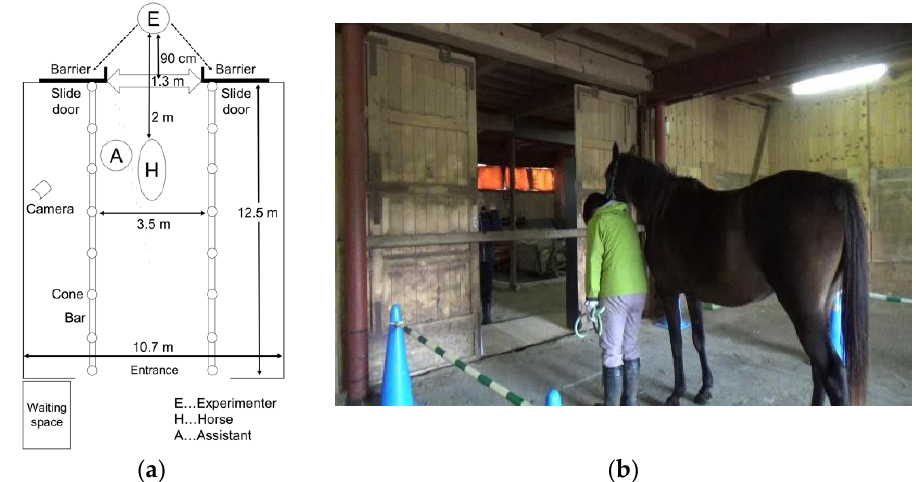
Figure 1. Setup for the study. ( a ) The experimental setting of the study: When the trial began, the experimenter (E) stood in front of the subject